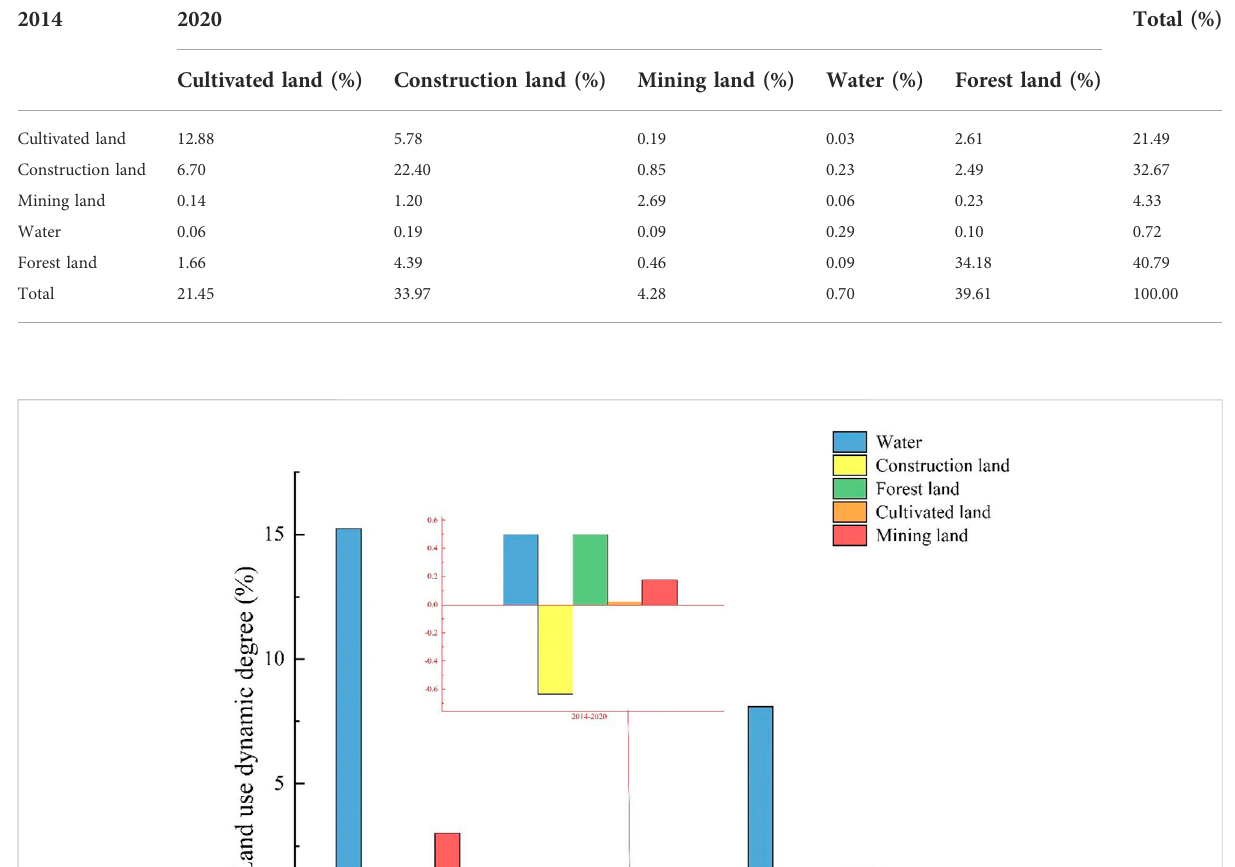
TABLE 5 Land use transfer matrix in Anshan urban area from 2014 to 2020.